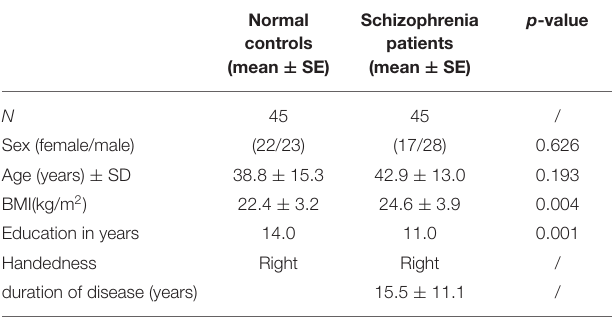
TABLE 1 | Participant